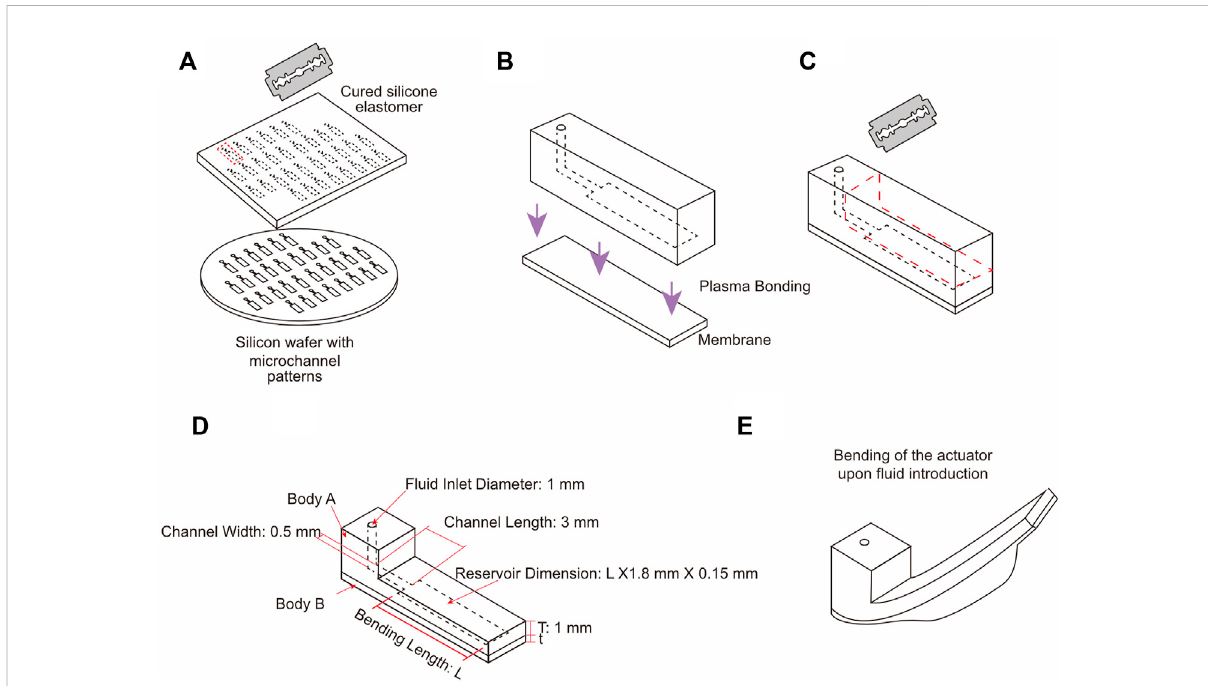
FIGURE 1 Schematic depicting the process of balloon actuator fabrication. (A) Silicon wafers patterned with microchannels were used as molds for soft lithography of Body A. (B) Inlet was punched into Body A which was then bonded to Body B (membrane prepared using spin coating) using oxygen plasma (C) Body A was trimmed to maintain a thickness of 1 mm over the microchannel of all actuators. (D) Dimensions of different parts of the actuator. (E) Bending of the actuator upon fl uid introduction.